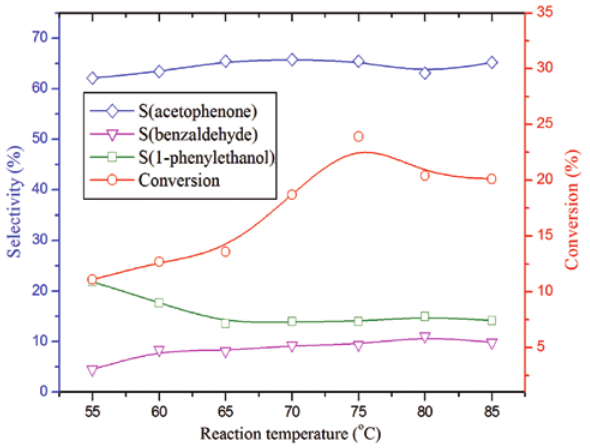
Figure 4: Effect of reaction temperature on the conversion and selectivity over activated carbon supported Co (AC-CoPW) catalyst. Reaction conditions: (H volume ratio = 2.5; P(CO (co-catalyst) = 0.25